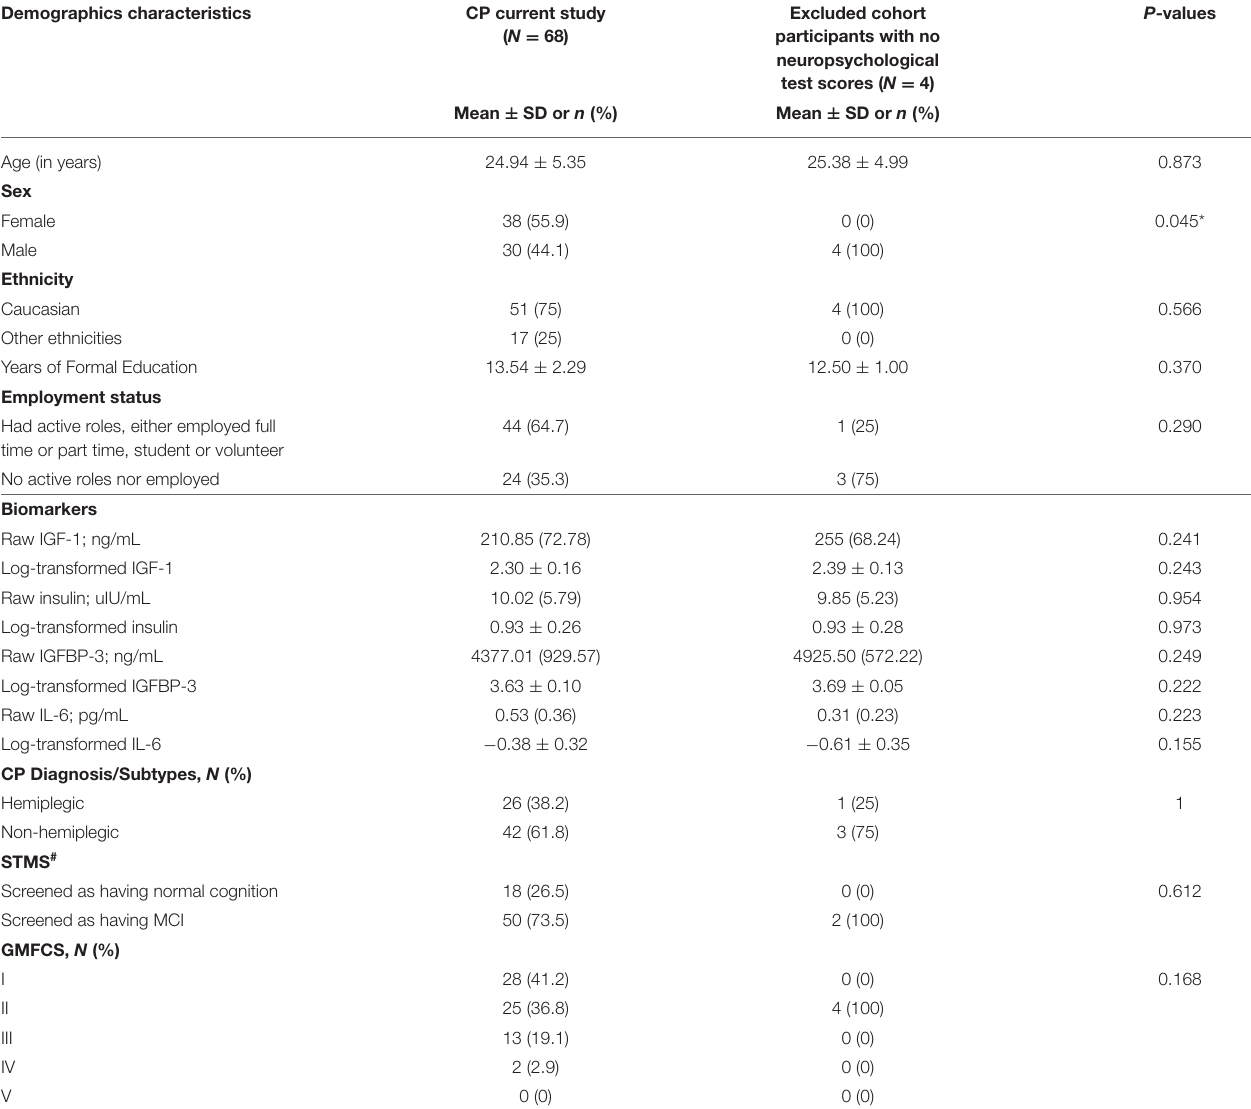
TABLE 1 | Demographics, clinical characteristics, and biomarker data of study